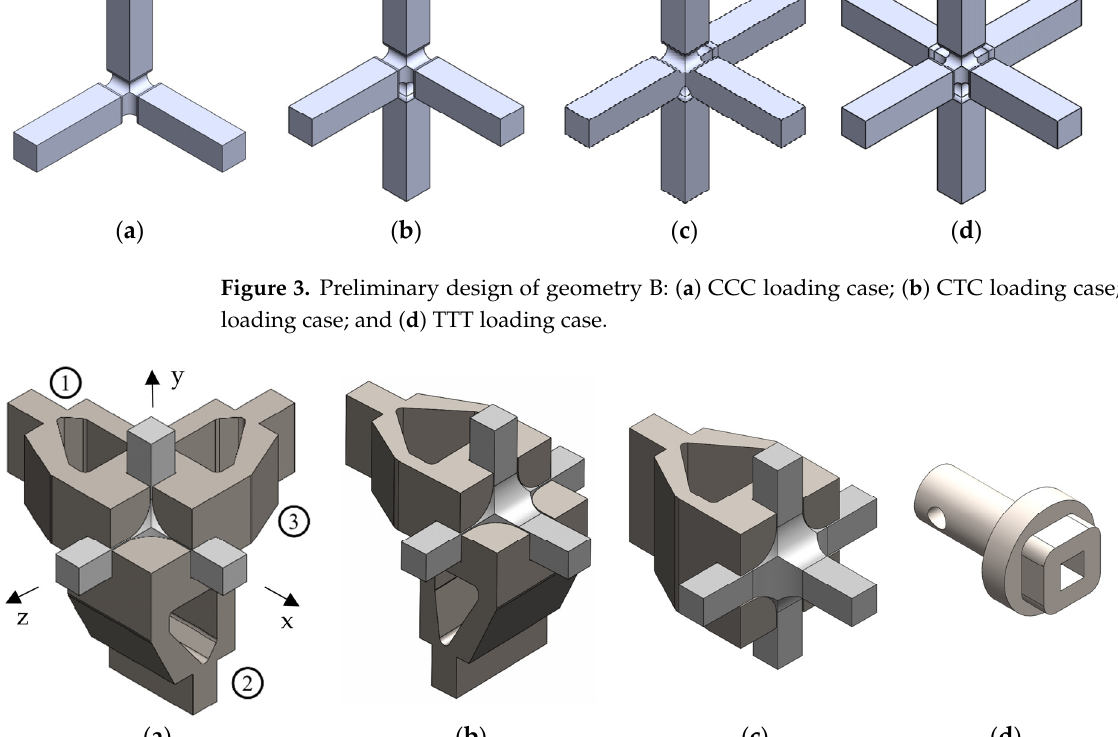
Figure 4. Supporting fixture of the specimen applied to geometry A. The fixture consists of three supporting parts which are numbered in (a) for the x-, y- and z-axes with the etiquettes 1, 2, and 3 respectively. ( a ) CCC loading case; ( b ) CCT loading case; ( c ) CTT loading case; and ( d ) compression platens.